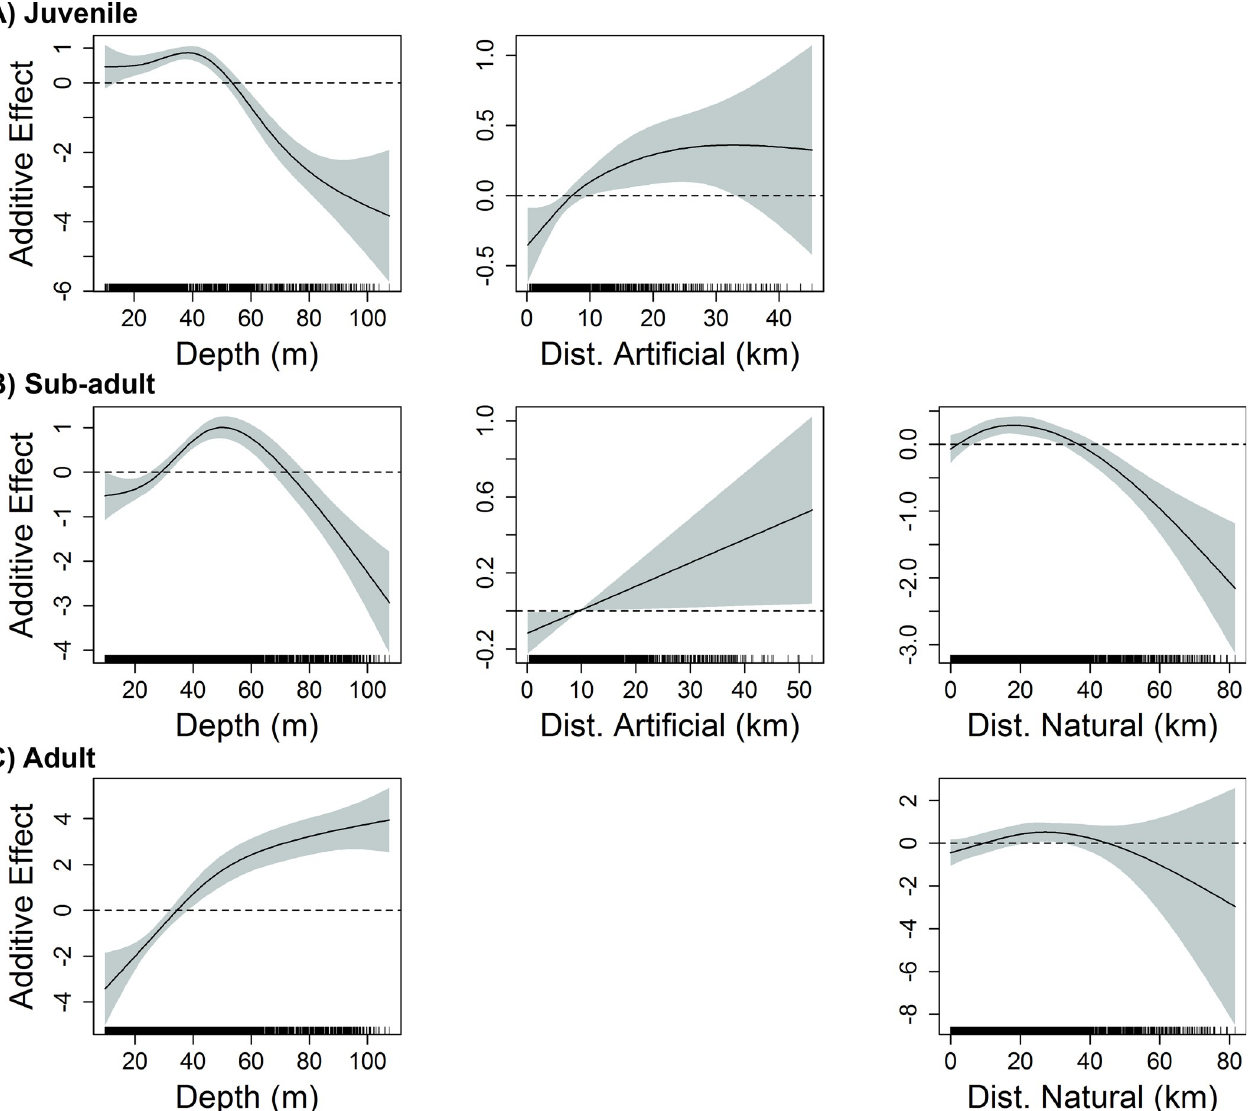
Fig 5. Influence of benthic habitat variables on red snapper abundance in the western GoM. Response plots from final generalized additive models show the influence of depth (m), distance to artificial structure (Dist. Artificial), and distance to natural hard bottom habitat (Dist. Natural) on the abundance of A) juvenile (age-0), B) sub-adult (age-1-2), and C) adult (age-2+) red snapper over unconsolidated bottom in the western GoM. Solid lines represent smoothed values, and shaded areas represent 95% confidence intervals. Dashed lines are included at y =